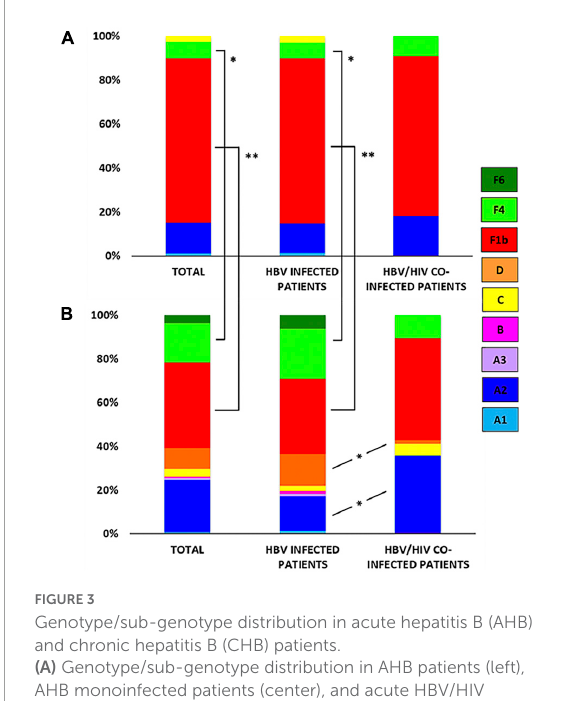
FIGURE3 Genotype/sub-genotype distribution in acute hepatitis B (AHB) and chronic hepatitis B (CHB) patients. (A) Genotype/sub-genotype distribution in AHB patients (left), AHB monoinfected patients (center), and acute HBV/HIV co-infected patients (right). (B) Genotype/sub-genotype distribution in CHB patients (left), CHB monoinfected patients (center), and chronic HBV/HIV co-infected patients (right). References: A1, light blue; A2, blue; A3, lavender; B, fuchsia; C: yellow; D: orange; F1b: red; F4: light green; F6: green; ∗ p < 0.05; ∗∗ p <